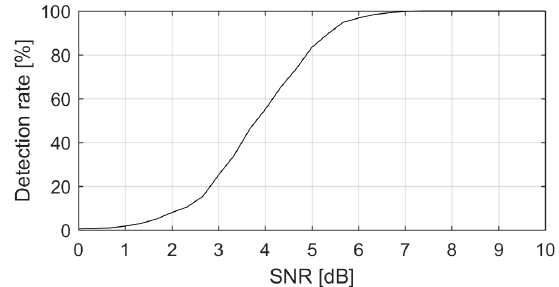
Figure 15. Percentage of detected AP versus SNR.